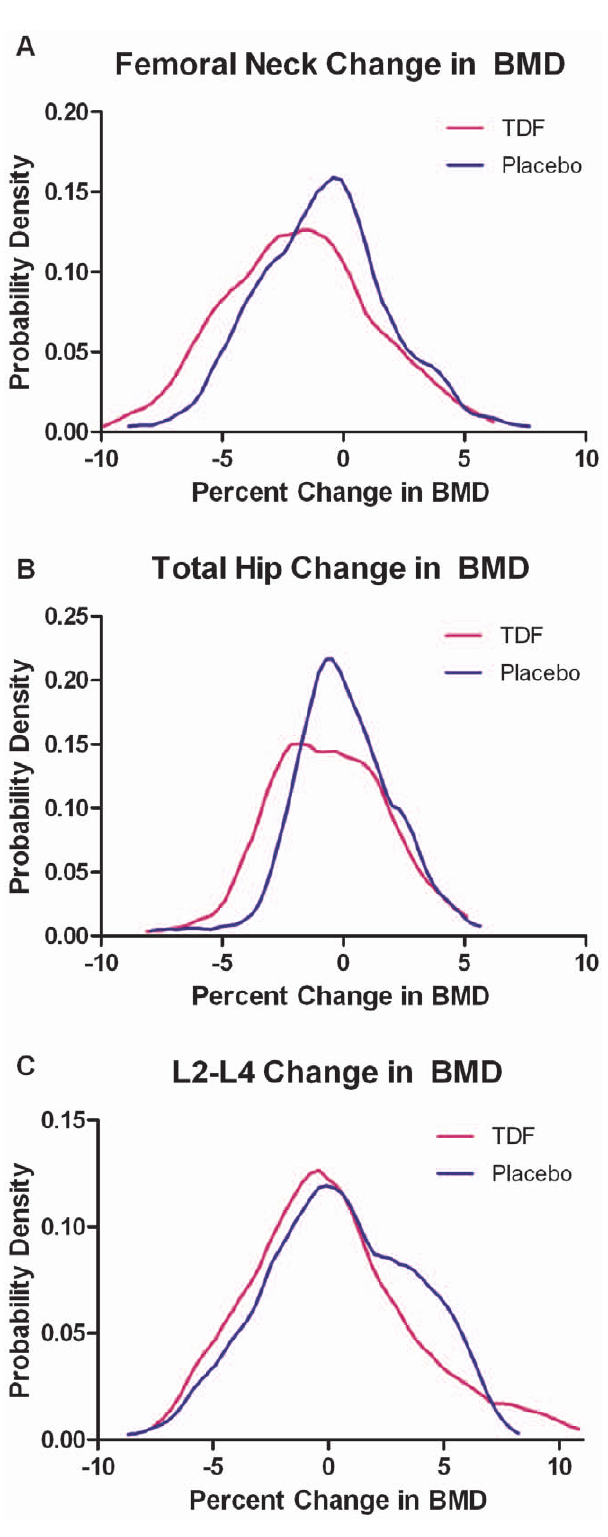
Figure 4. Normal curves demonstrating percent changes in bone density at 24 months in the placebo vs. TDF groups, by anatomic site. Distribution curves of percent BMD change from baseline at last scan at the femoral neck (a), total hip (b), L2–L4 spine (c). BMD, bone mineral density;TDF, tenofovir disoproxil fumarate.